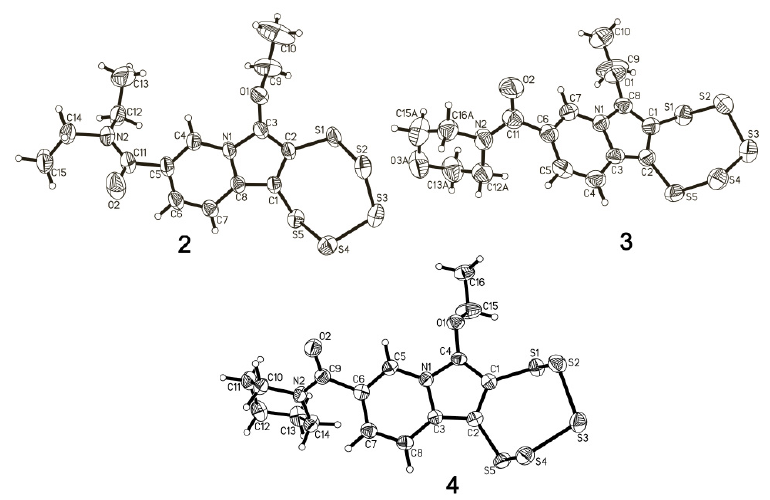
Figure 4. The crystal structures of compounds 2 – 4 shown with ellipsoids at the 50% level. Minor occupancy disorder atoms of the morpholine ring in 3 were omitted for clarity